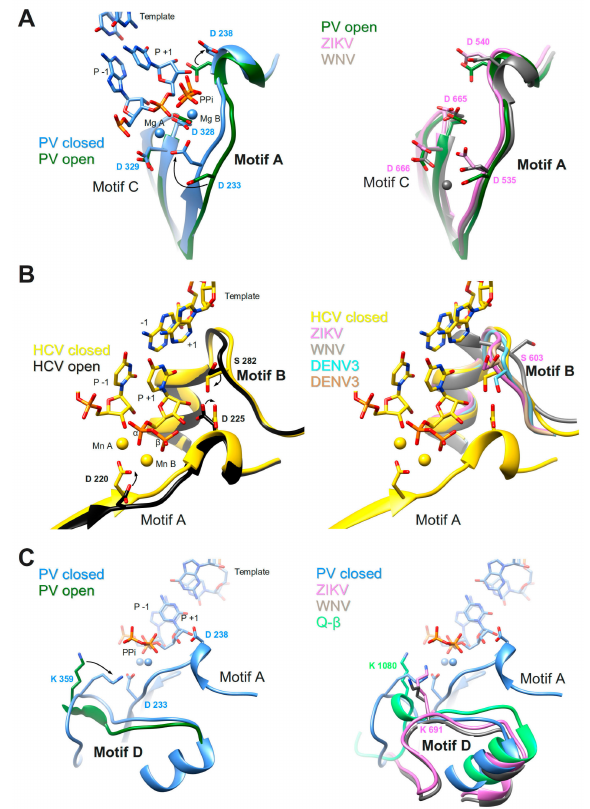
Figure 5. Conformational changes of motifs A, B, and D of PV RdRp and/or HCV RdRp upon reaction (left panels) in comparison to motif conformations of Flavivirus RdRps (right panels). ( A ) Motif A; left panel: ribbon representation of PV RdRp (PV closed, PDB ID: 3OL7, blue) in complex with template (only the base part of − 1 and +1 shown) and product (only P − 1 and P+1 shown) represented in sticks (colored according to atom type: C, blue; O, red; P, orange), and two Mg 2+ ions as blue spheres, just after the incorporation of P+1. The liberated pyrophosphate (PPi) is still present at the catalytic site. PV open (PDB ID: 3OL6, dark green) corresponds to a complex after reaction and translocation. Only the protein is shown. Selected amino acid side chains are shown and colored according to atom type. Conformational changes are indicated by black arrows. Right panel: PV open as in the left panel superimposed to ZIKV RdRp (PDB ID: 5UOC, orchid) and WNV RdRp (PDB ID: 2HFZ, grey). The Mg 2+ ion (grey) belongs to the WNV RdRp structure. ( B ) Motif B; left panel: ribbon representation of HCV RdRp (HCV closed, PDB ID: 4WTA, gold) in complex with template (only − 1 and +1 nucleobases are visible), product (only P − 1 shown), and incoming UDP (P+1) represented in sticks (colored according to atom type: C, gold; O, red; P, orange), and two Mn 2+ ions as golden spheres. HCV open (PDB ID: 2XI2, black) corresponds to the apo enzyme. Selected amino acid side chains are shown and colored according to atom type. Conformational changes are indicated by black arrows. Right panel: HCV closed, as in the left panel, superimposed to ZIKV RdRp (PDB ID: 5UOC, orchid), WNV RdRp (PDB ID: 2HFZ, grey), DENV3 NS5 (PDB ID: 4V0Q, light blue) and DENV3 NS5 (PDB ID: 5CCV, brown). ( C ) Motif D; left panel: PV closed (PDB ID: 3OL7, blue) with template, product, and PPi (see explanation in ( A ). A larger protein stretch than only motif D is shown including the helix before and the loop after motif D. For PV open (PDB ID: 3OL6, dark green) only the protein region is shown that corresponds to motif D as given in Figure 4. Selected amino acid side chains are shown and colored according to atom type. A conformational change of the loop and residue K359 is indicated by a black arrow. Right panel: larger motif-D stretch of PV closed shown with template, product, and PPi as in the left panel, and superimposed to ZIKV RdRp (PDB ID: 5UOC, orchid), WNV RdRp (PDB ID: 2HFZ, grey) and bacteriophage Q- β RdRp (PDB ID: 3AVT, green). Selected amino acid side chains are shown and colored according to atom